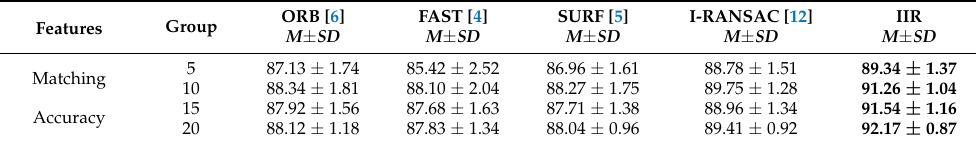
Table 4. The information of matching accuracy with different groups of images.